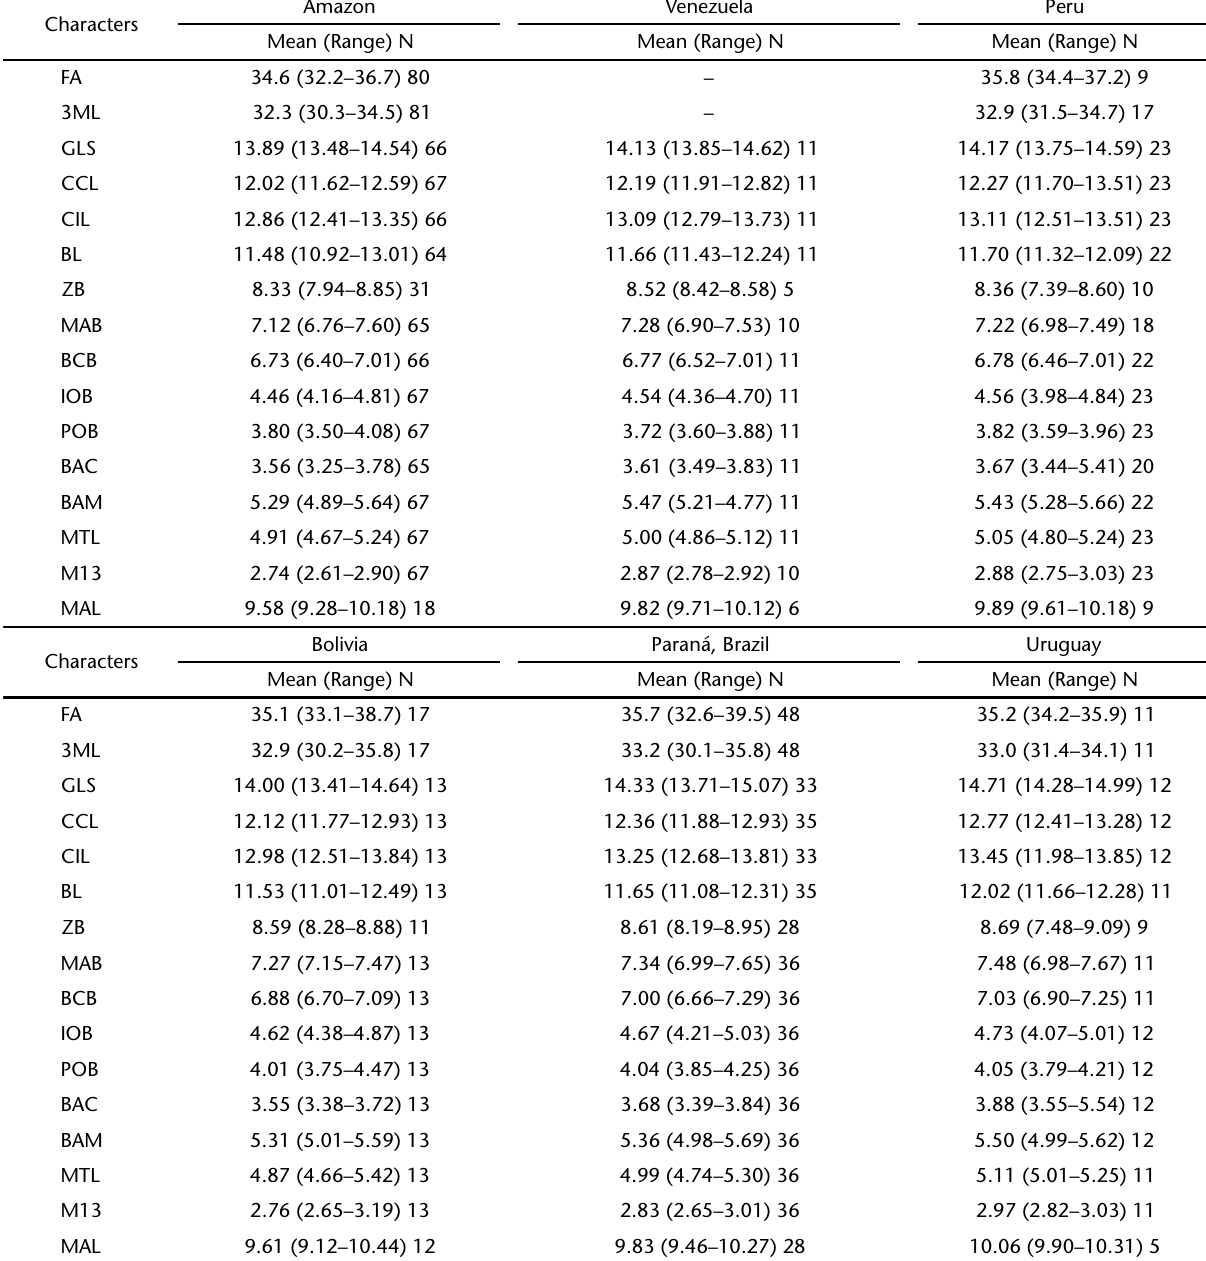
Table I. Descriptive statistics, with measurements given in millimeters, for geographic samples (groups 1-6) of Myotis albescens , with males and females